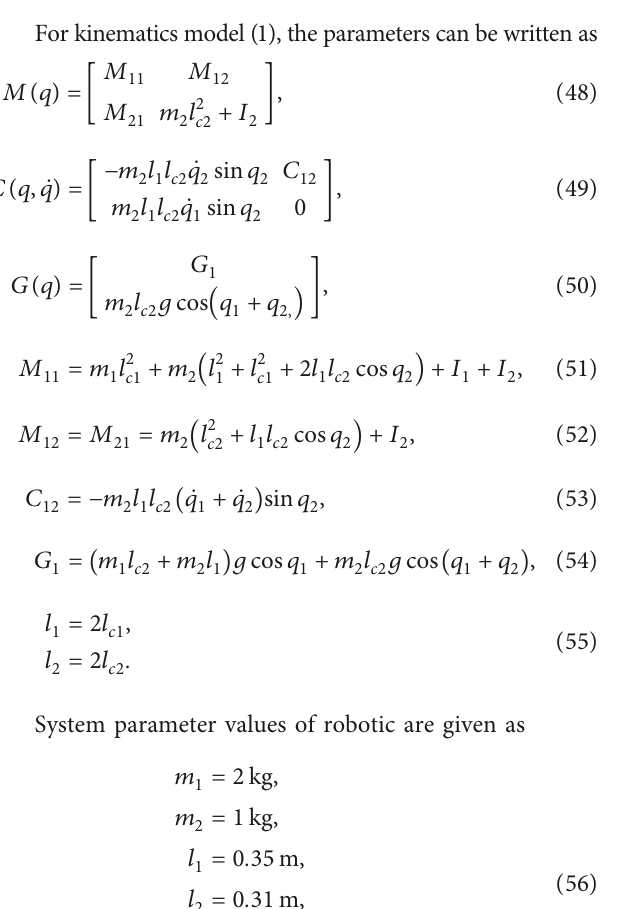
q 1 and 2 with the single NN-